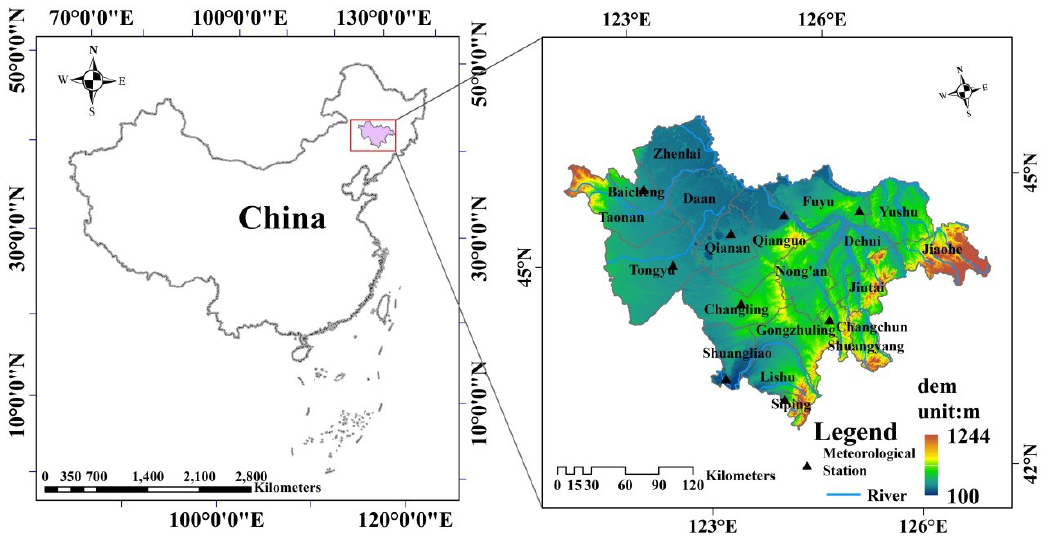
Figure 1. Location map of the study area in China.